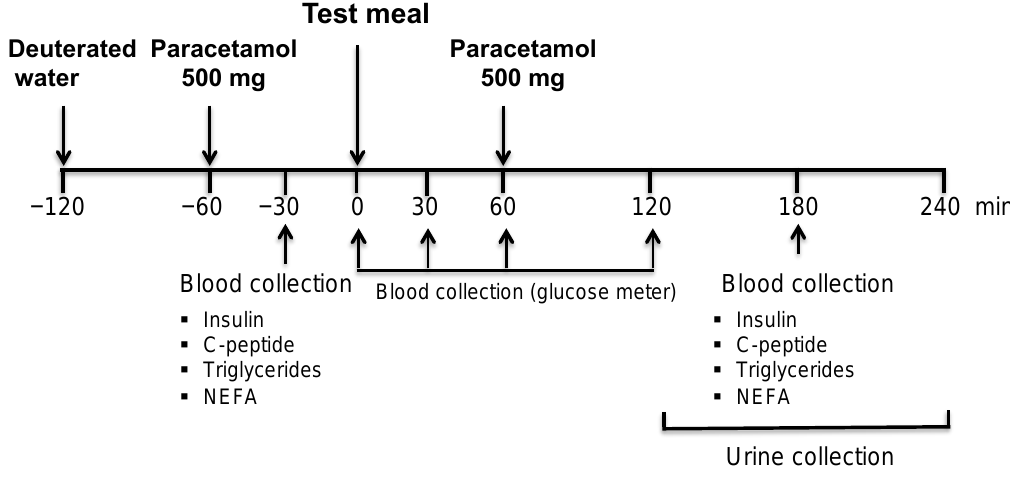
Figure 2. Description of the study protocol.